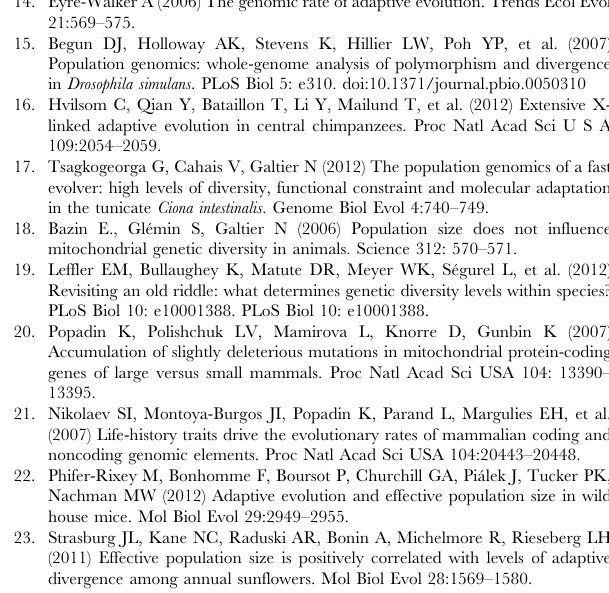
Table S2 Robustness of population genomic statistics to several SNP calling options. Text S1 Detection of hidden paralogy in polymorphism datasets generated by mapping reads to a reference theory and